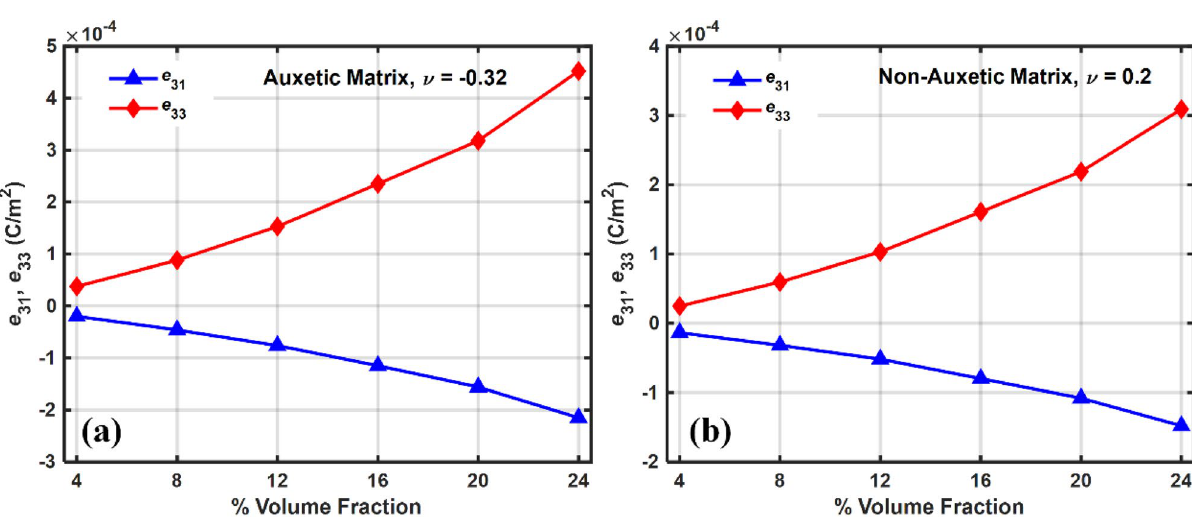
Figure 7. Plot of effective piezoelectric coefficients vs. volume fraction for ( a ) Auxetic material ( b ) Non-Auxetic